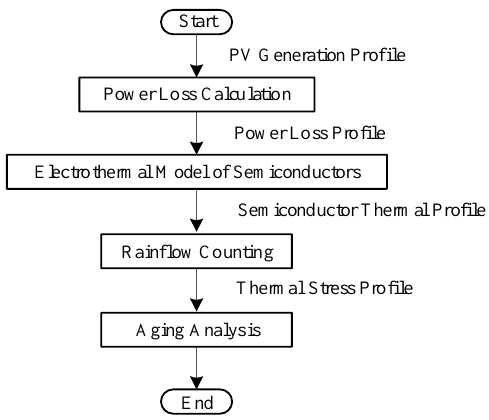
Figure 11. Flow chart of the proposed fatigue simulation [40].